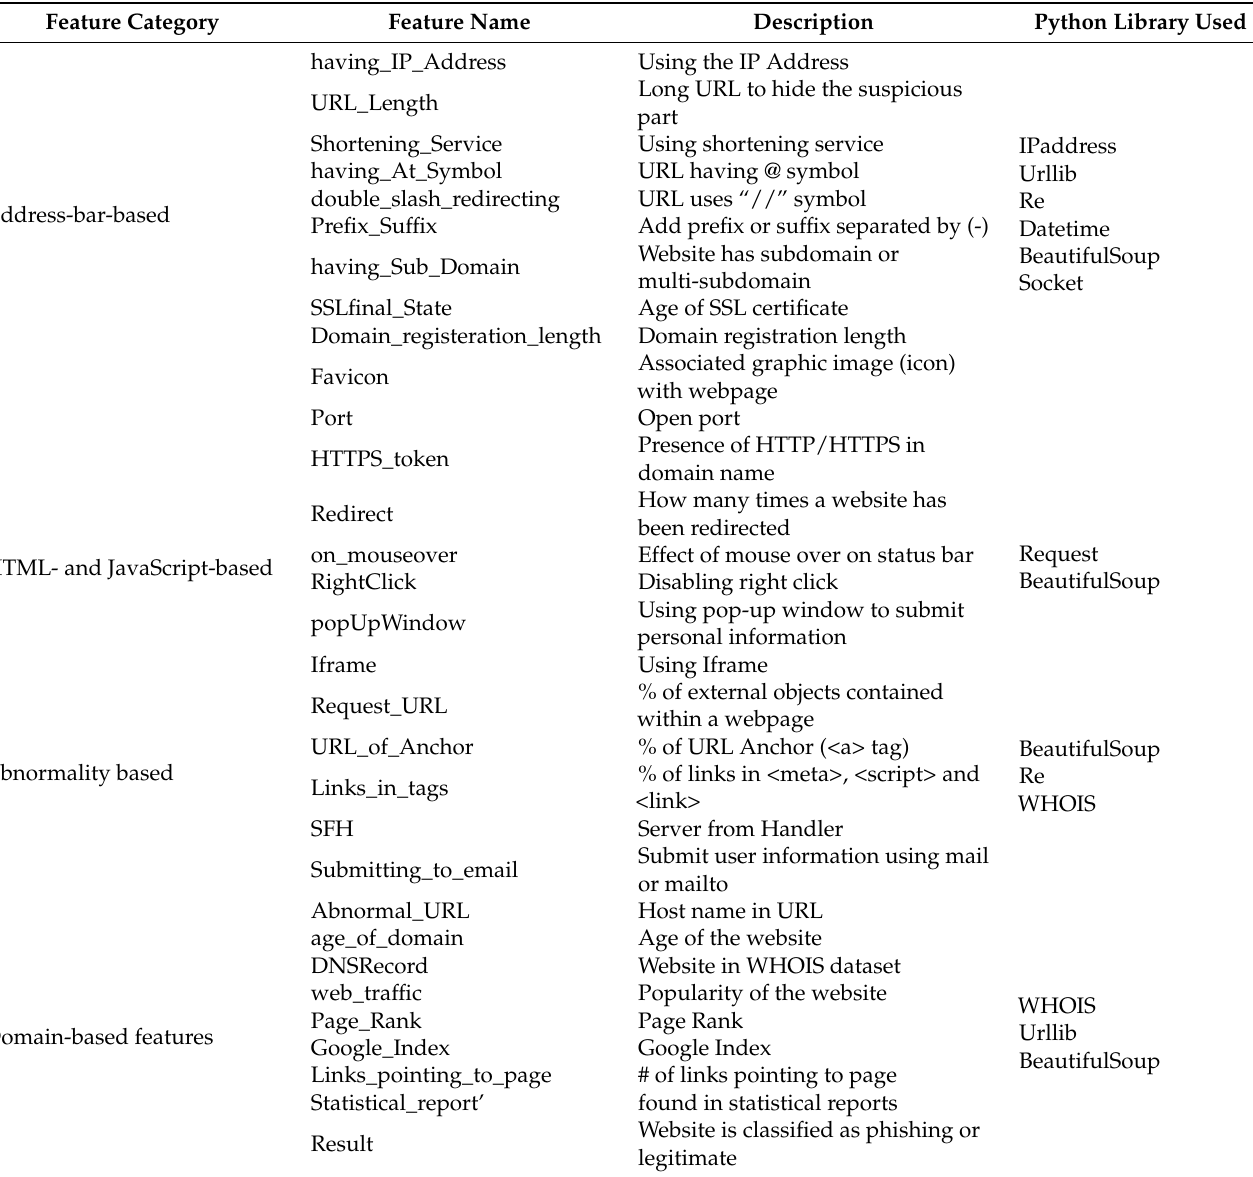
Table 1. Feature description for phishing